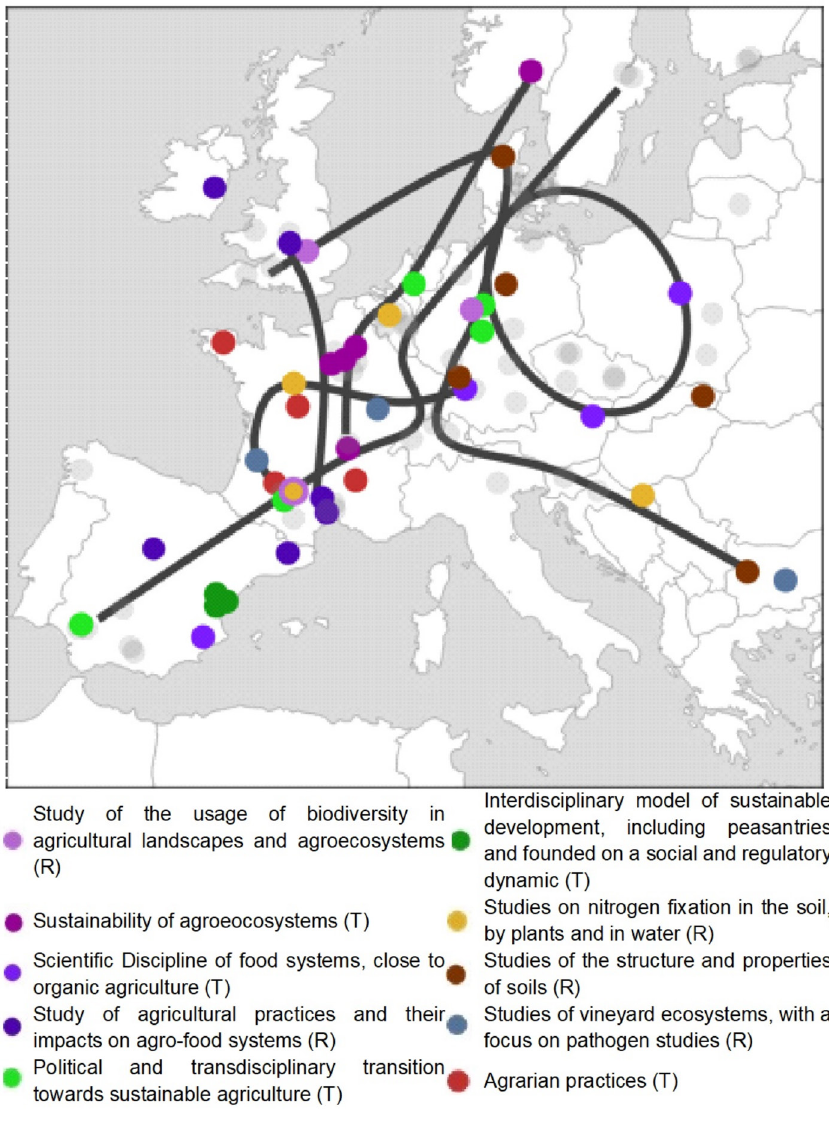
Figure 9: Direct and semantic networks of research and training